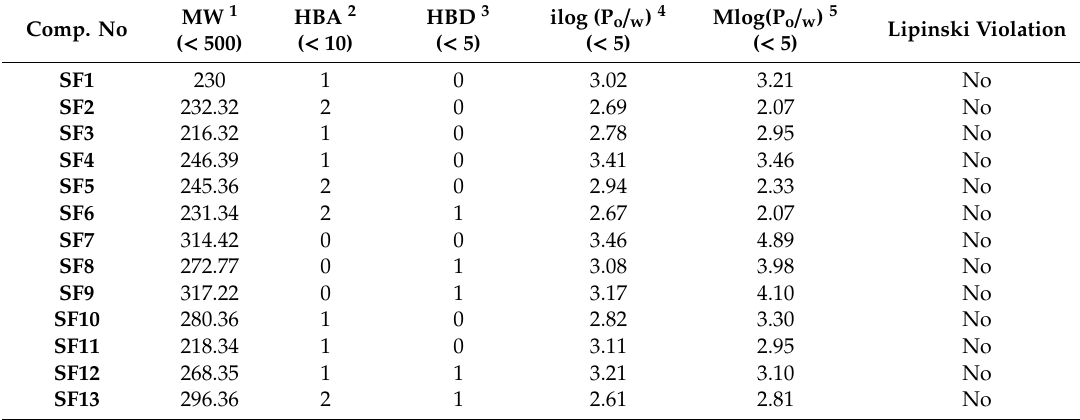
Table 1. Lipinski’s rule of five for the drug-likeness of all synthesized compounds ( SF1 – SF13 ). MW 1 HBA 2 Comp. No ( < 500)